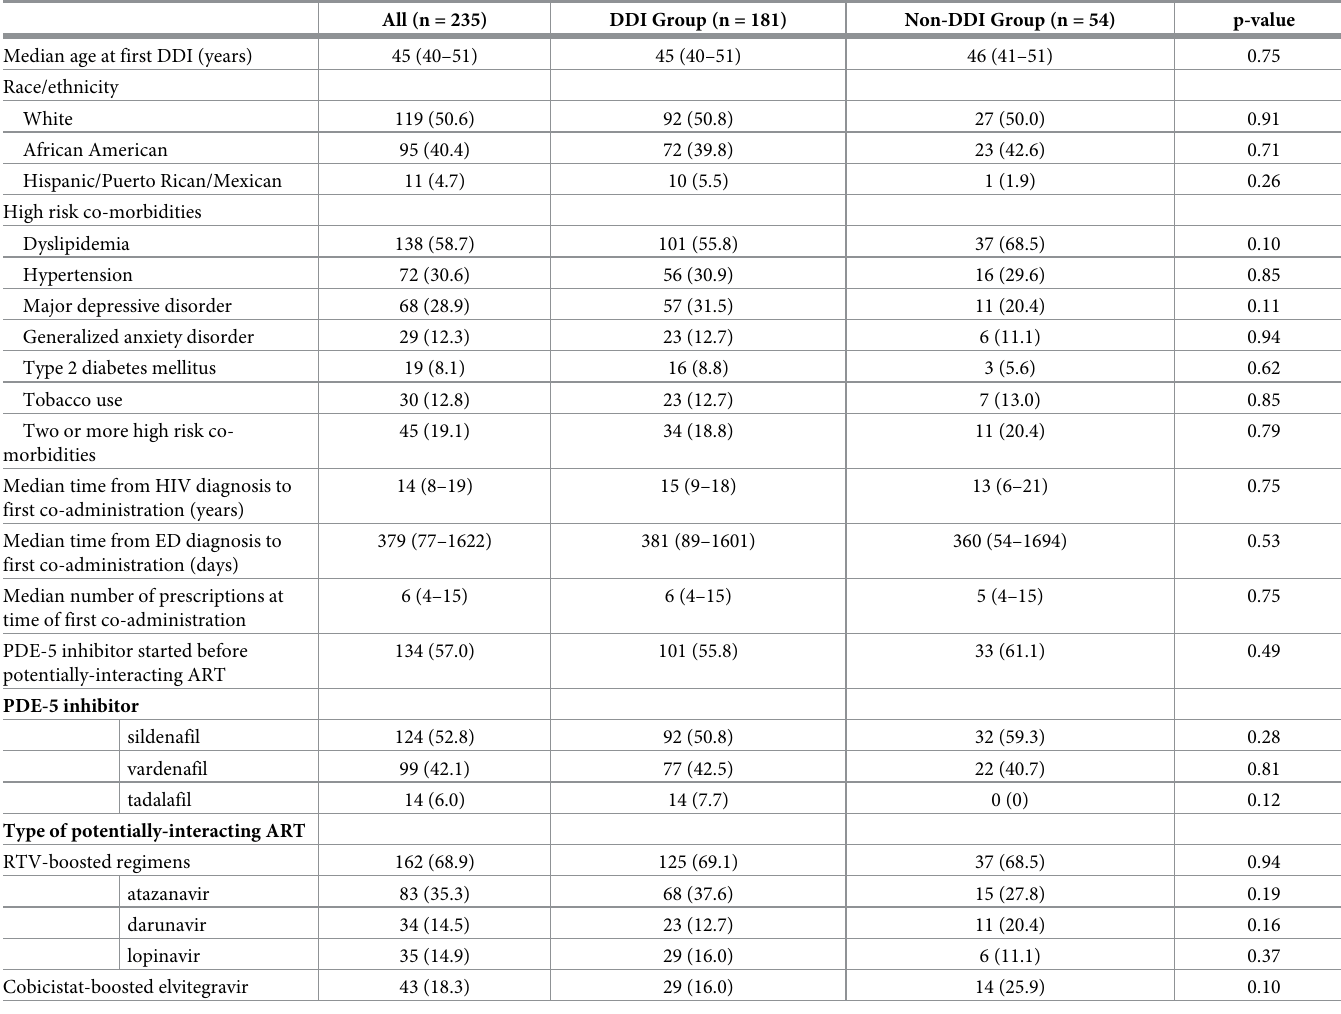
Table 1. Participant